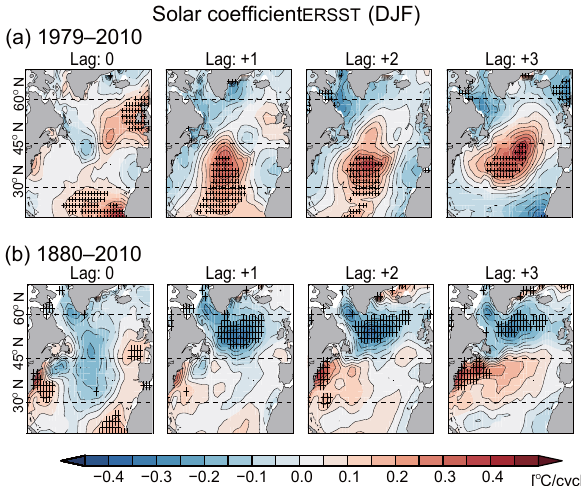
Figure 9. Solar regression coefficients of winter mean SST in the North Atlantic sector extracted from ERSST at lag times of 0, 1, 2 and 3 years, for (a) 1979 to 2010 and (b) 1880 to 2010. Stippled areas indicate statistical significance at the 90%